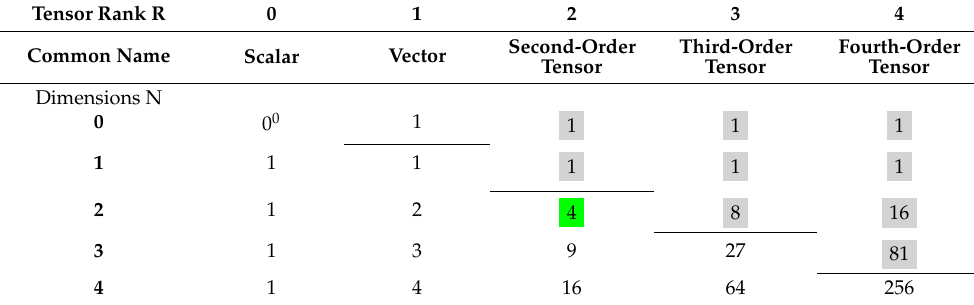
Table 1. Number of spatial object